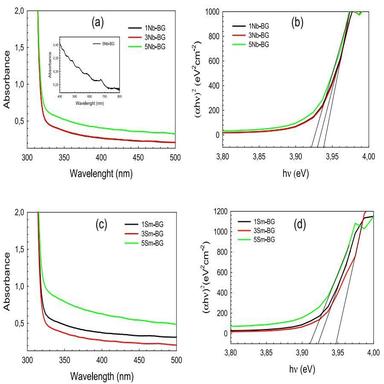
UV-absorption spectra (left column) and the Tauc plots (right column) of the (a), (b) Nb5+; (c), (d) Sm3+-containing bioactive glass particles in EC film matrix.